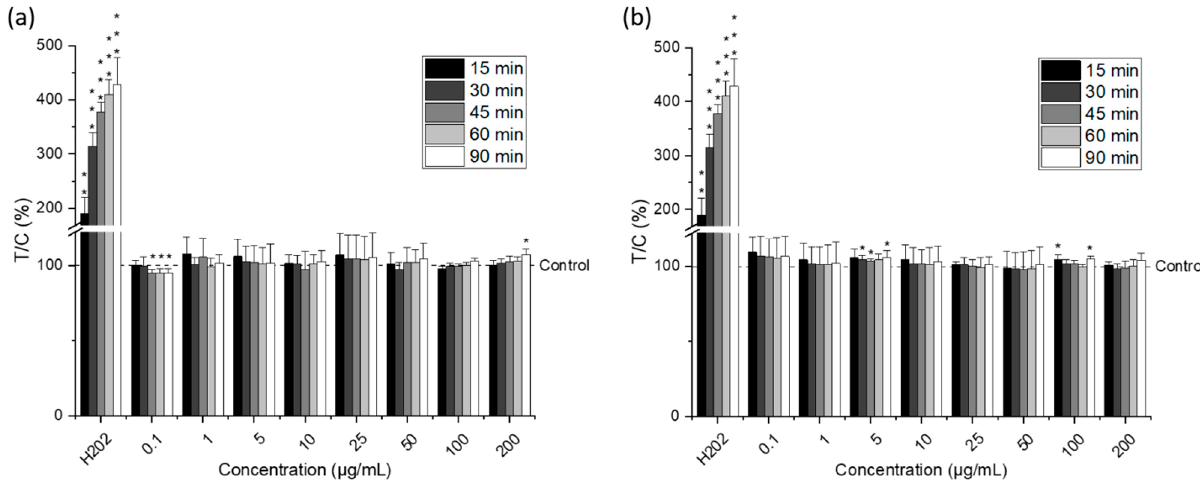
Figure 6. ROS levels in HCT-116 cells after different incubation times (15, 30, 45, 60, and 90 min) with different concentrations of the omega-3 lipid extracts produced by the traditional method ( a ) and the green method by using Saczyme ( b ) measured by the dichlorofluorescein (DCF) assay. Hydrogen peroxide (H 2 O 2 ) was used as positive control. Results are presented as mean + SD normalized to DMSO solvent control (0.5%; T/C in %) (n = 6). Statistical differences compared to the DMSO solvent control were calculated with a one-sample Student’s t -test (* p , ** p , *** p < 0.05, 0.01, 0.001).